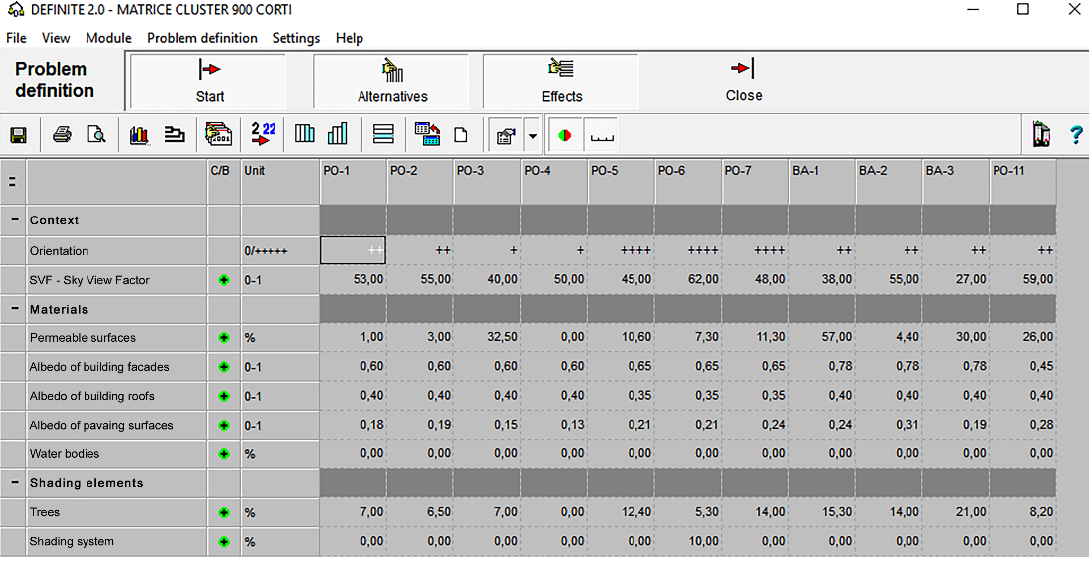
Figure 7. Example of a matrix of technological and morphological knowledge of the sample areas of urban pattern clusters.